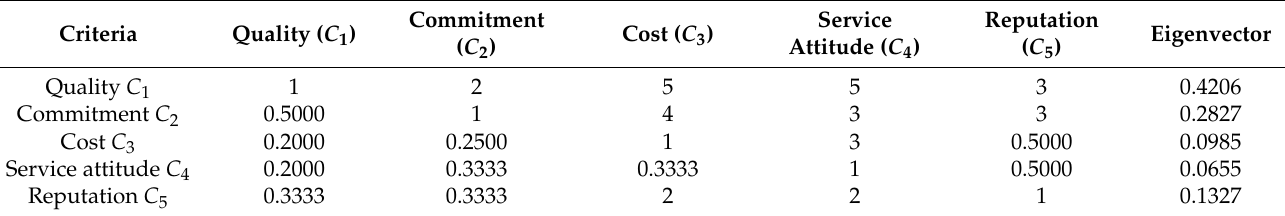
Table 5. Pairwise comparison matrix W 21 and the